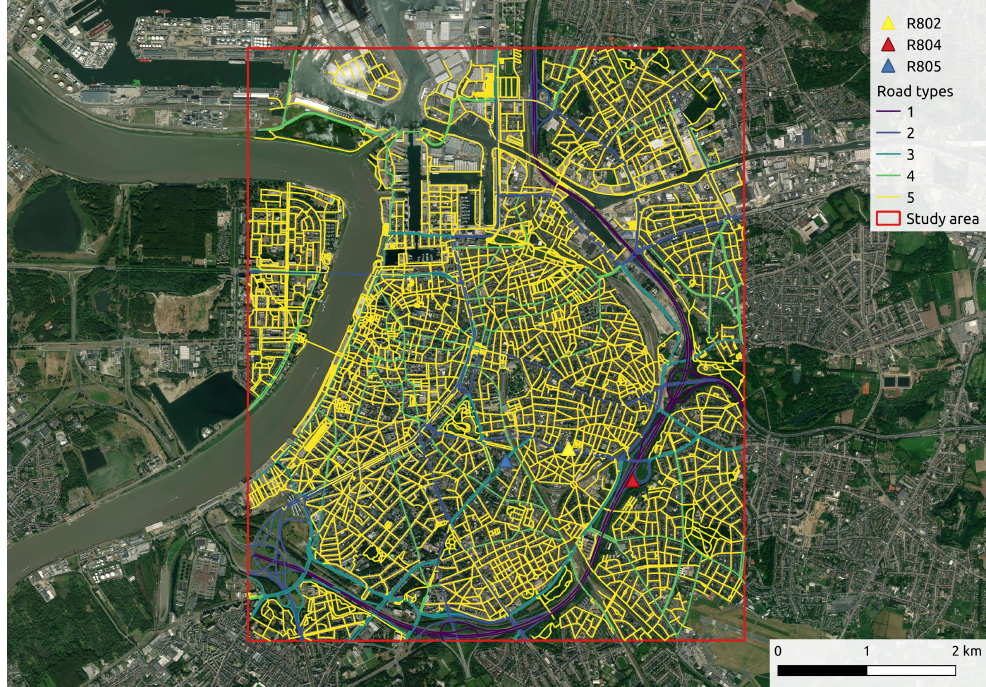
Figure 1. The location of study area in the city center of Antwerp and the road network in the area of interest. The locations of three stationary regulatory monitoring stations are marked by different colored